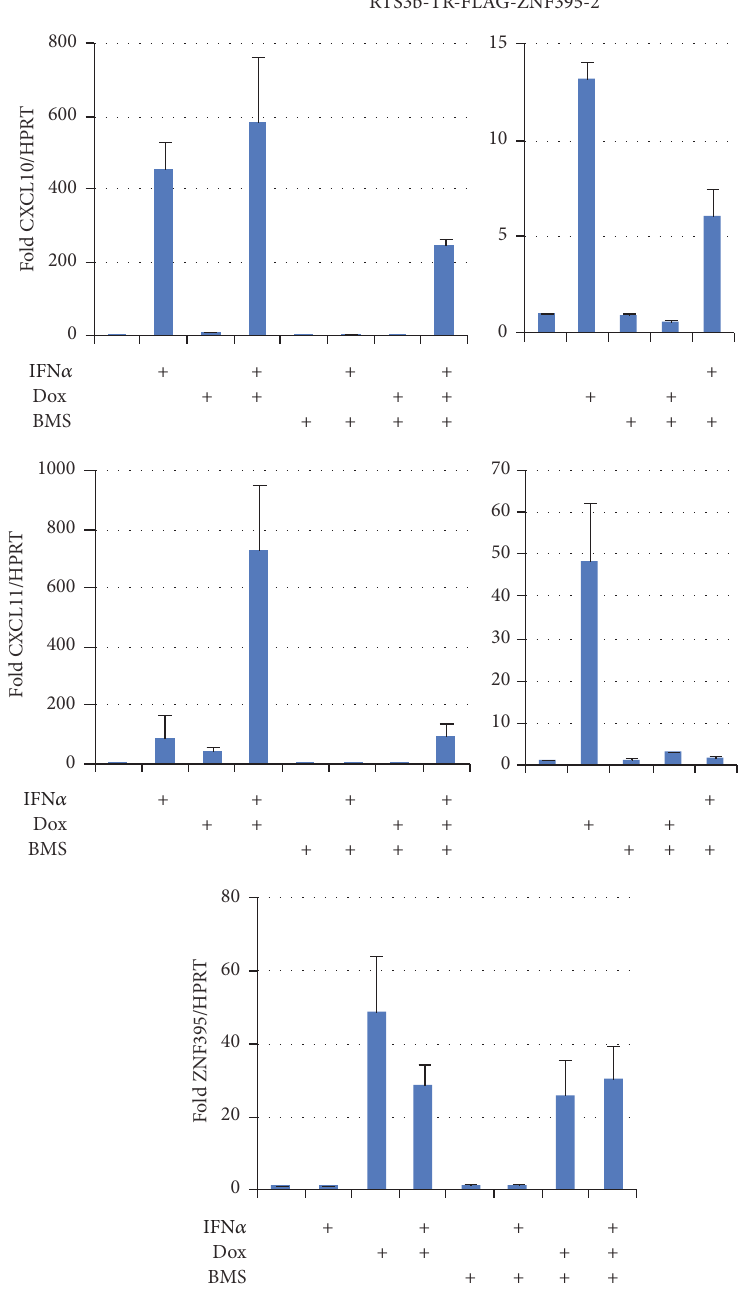
Figure 4: Activation of CXCL10 and CXCL11 expression by ZNF395 requires active IKK. RTS3b-TR-FLAG-ZNF395-2 cells were treated with Dox to induce the expression of ZNF395, with IFN 𝛼 and the IKK 𝛽 -specific inhibitor BMS-345541 in various combinations as indicated in the figure. QRT-PCR was performed to determine the level of transcripts for CXCL10, CXCL11, and ZNF395. After normalization with the house keeping gene HPRT, the values obtained with untreated cells were set as 1 and fold changes upon the different treatments were calculated by Δ -threshold method. The diagrams on the right are provided for a better resolution. The graphs represent the results of three qRT-PCRs with RNA obtained from one experiment. The results have been confirmed with RNA from an independent second experiment (data not